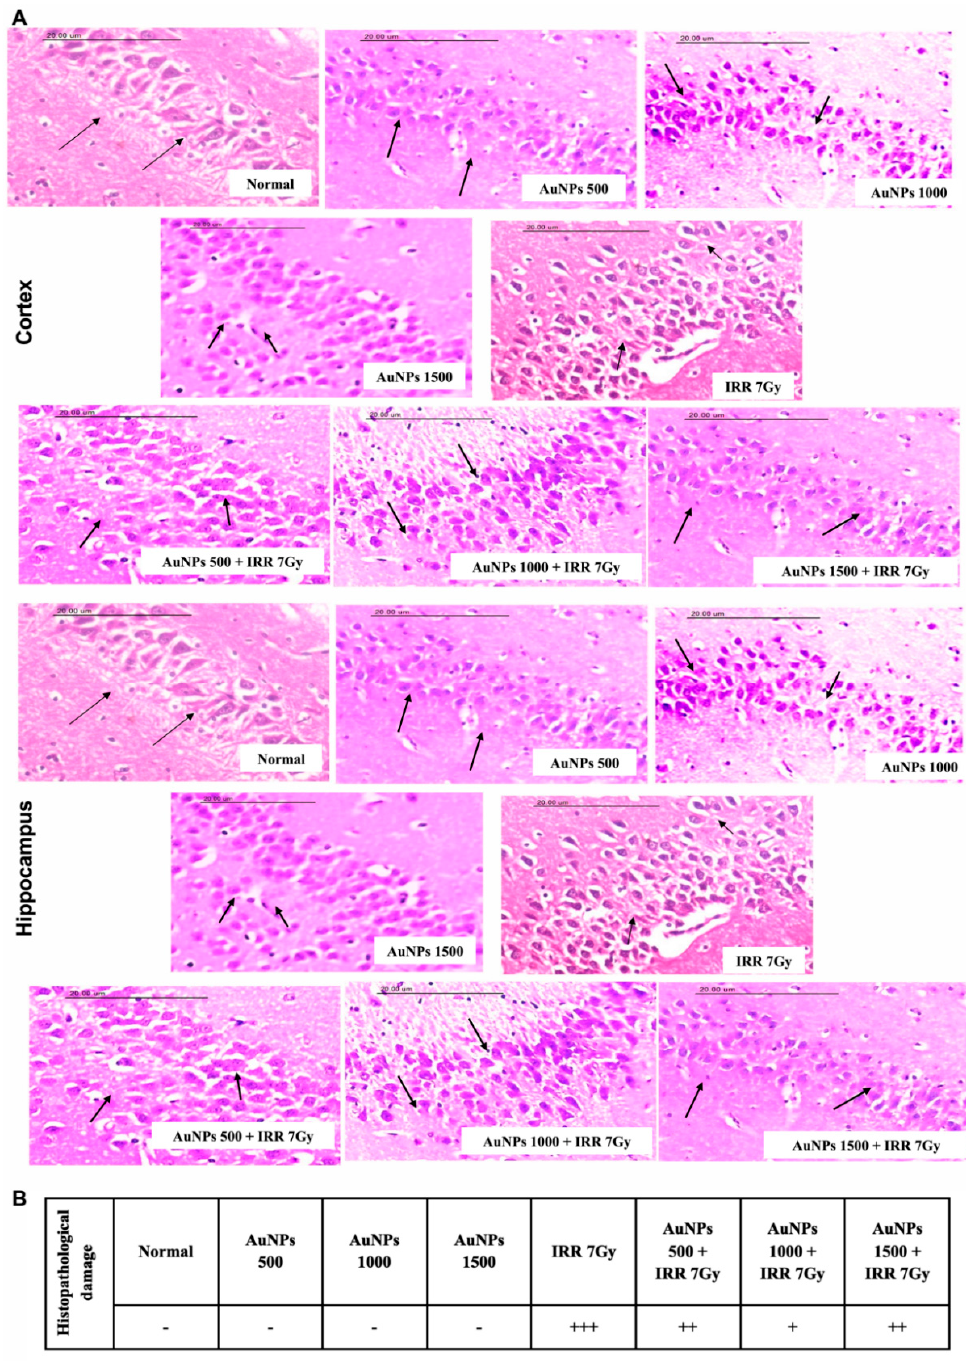
Figure 9. Effect of single oral administration of different doses of AuNPs on histopathological changes in cortical and hippocampal tissues of 7Gy-irradiated rats. ( A ) Sections of cortical and hippocampal specimens stained with H&E (scale bar is 20 µm). ( B ) Table showing the severity of histopathological damage.